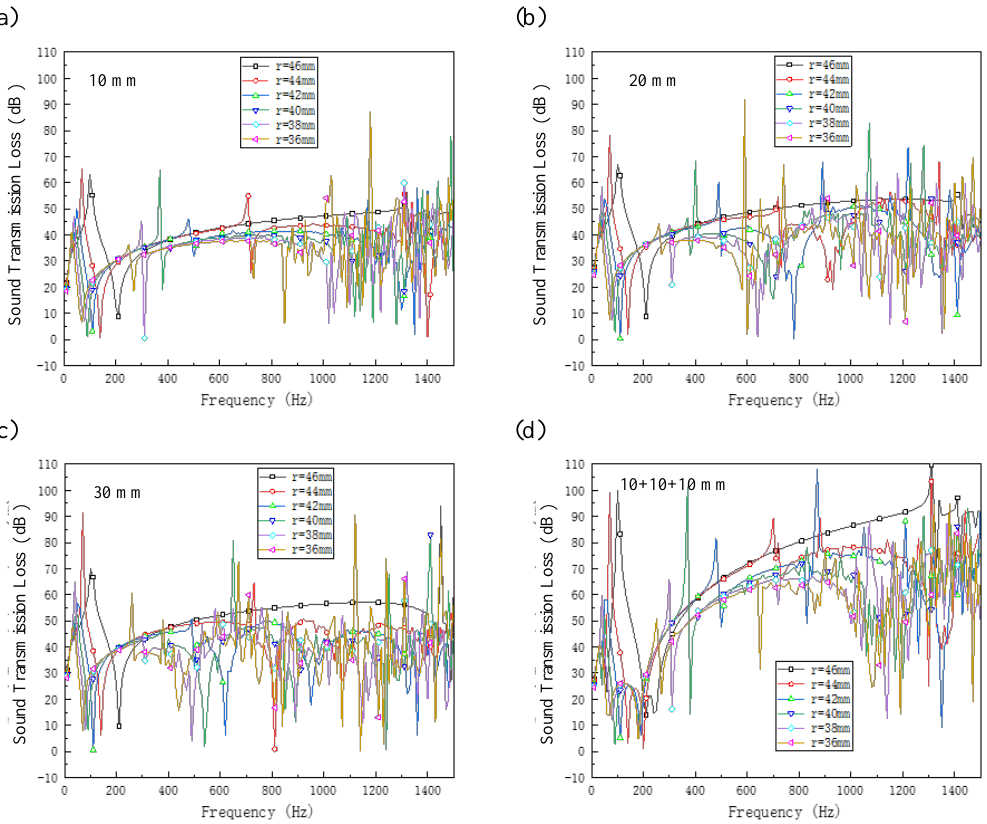
Figure 7. E ff ect of r on the STL: ( a ) e ff ect of r on the STL for a 10 mm-thick phononic crystals plate, ( b ) e ff ect of r on the STL for a 20 mm-thick phononic crystals plate, ( c ) e ff ect of r on the STL for a Figure 7. Effect of r on the STL: ( a ) effect of r on the STL for a 10 mm-thick phononic crystals plate, 30 mm-thick phononic crystals plate, and ( d ) e ff ect of r on the STL of the phononic crystals cavity ( b ) effect of r on the STL for a 20 mm-thick phononic crystals plate, ( c ) effect of r on the STL for a 30 mm-thick phononic crystals plate, and ( d ) effect of r on the STL of the phononic crystals cavity plates.